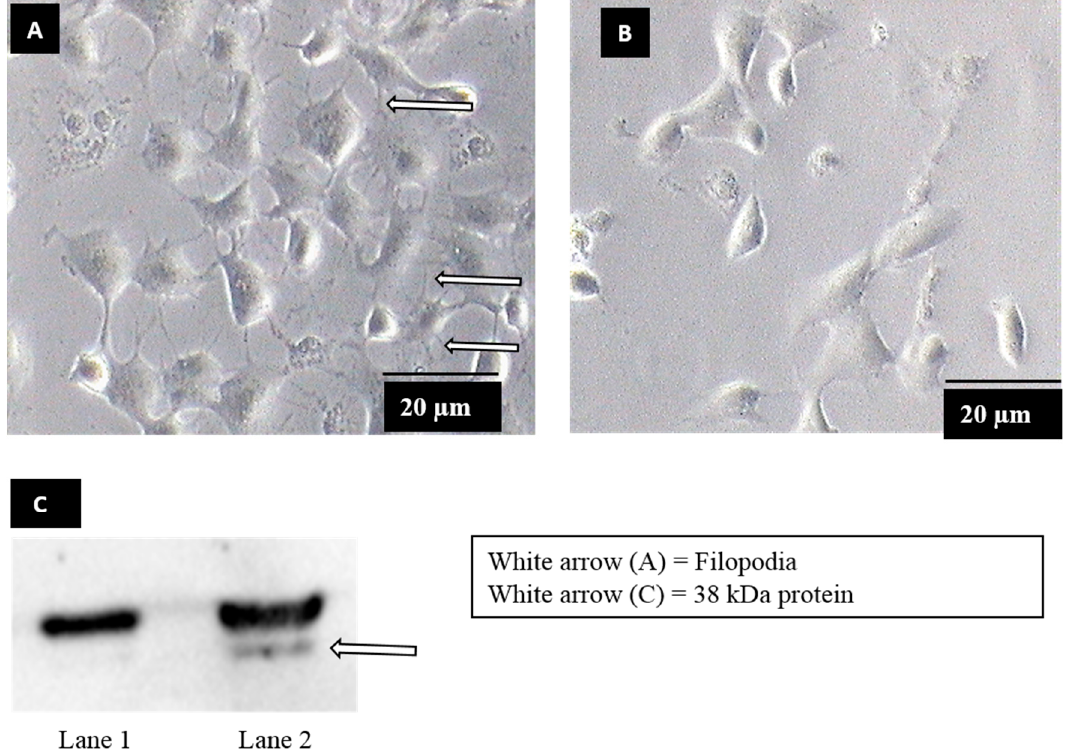
Figure 1. Production of filopodia in dengue virus serotype (DENV) infection and virus overlay protein binding assay (VOPBA) analysis. ( A ) Vero cells were exposed to DENV2 at a multiplicity of infection (MOI) 5, for 30 min. The arrows showed filopodia at the periphery of DENV exposed cells. ( B ) Mock exposed Vero cells showed no filopodia formation. ( C ) A blot of VOPBA analysis of DENV binding to plasma membrane protein extracted from mock-induced (lane 1) and filopodia-induced (Vero cells treated with 200 ng of bradykinin) cells (lane 2). The arrow showed an approximately 38 kDa protein (lane 2) was identified to segregate with DENV2 binding on bradykinin-induced cells.